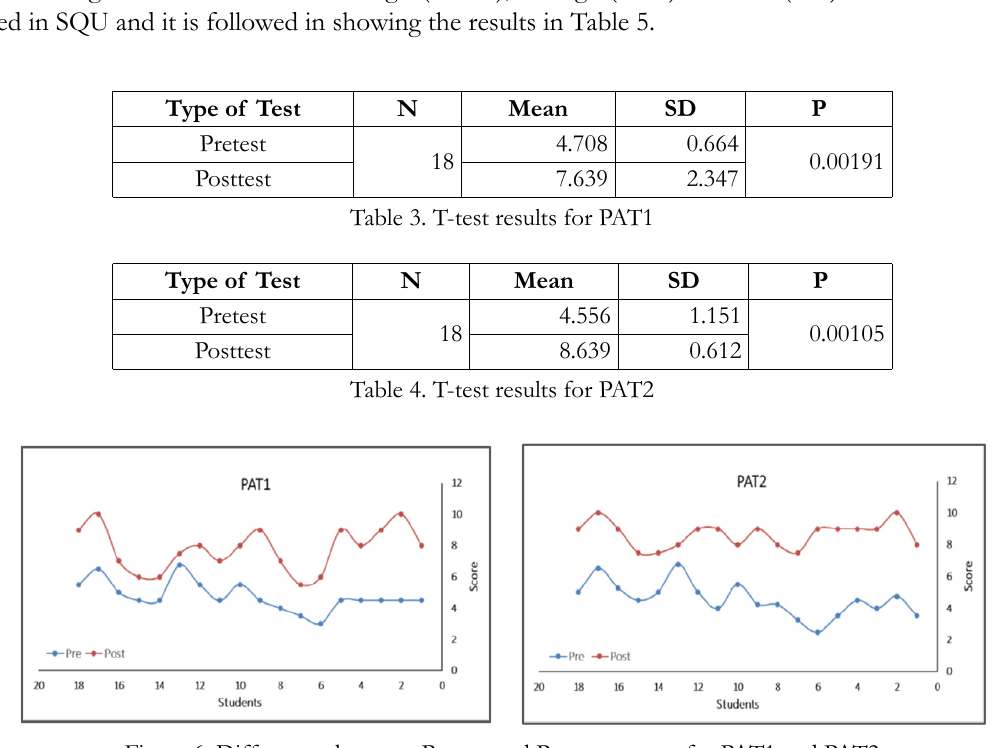
Figure 6. Differences between Pretest and Posttest scores for PAT1 and